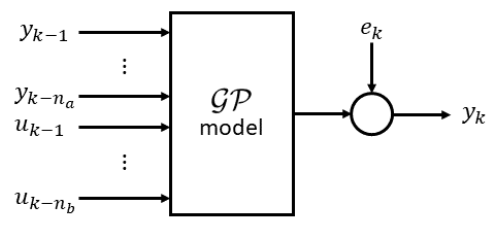
Figure 1. GP-NARX